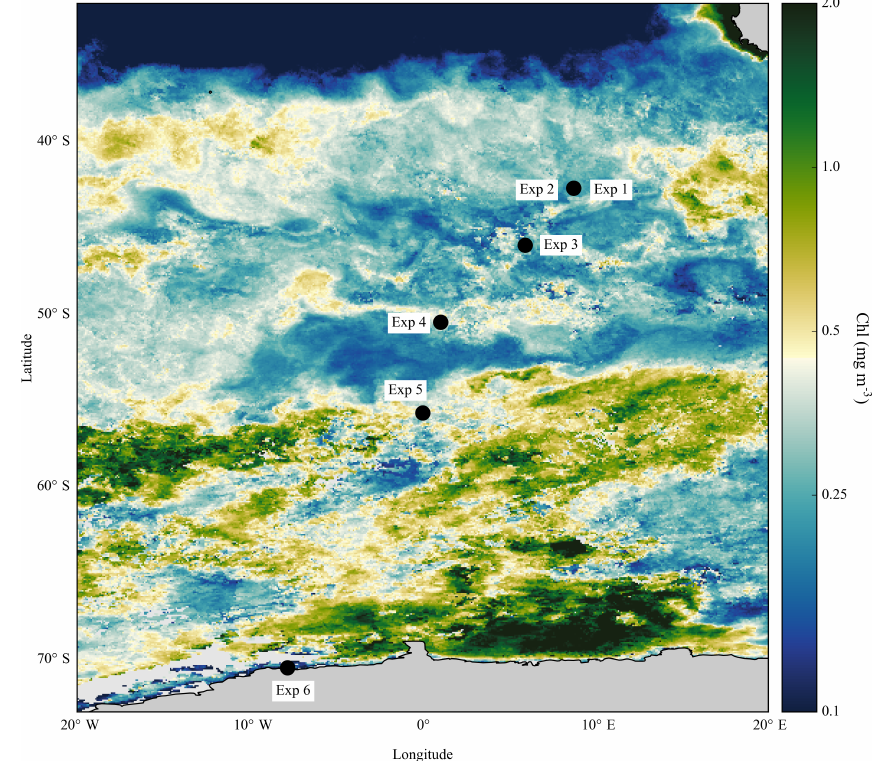
Figure 1. Composite map of MODIS (8 days, 9km) derived chlorophyll (mgm − 3 ) from November 2015 to March 2016 for the Atlantic sector of the Southern Ocean with locations of the nutrient addition productivity versus irradiance ( PE )